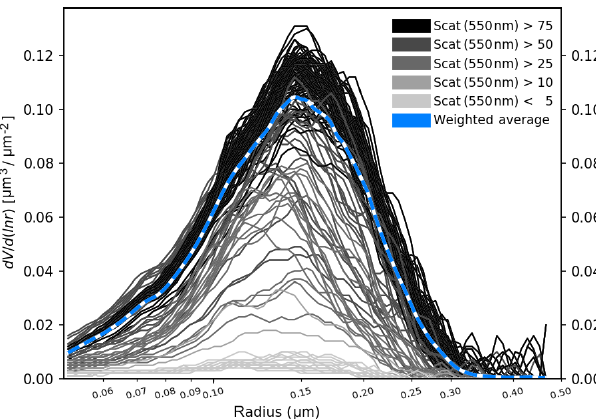
Figure 2. An example of the individual LARGE aerosol 1s sample size distributions from UHSAS (and scattering weighted average) from a full 22min aircraft profile at Essex (MD) on 5 July 2011